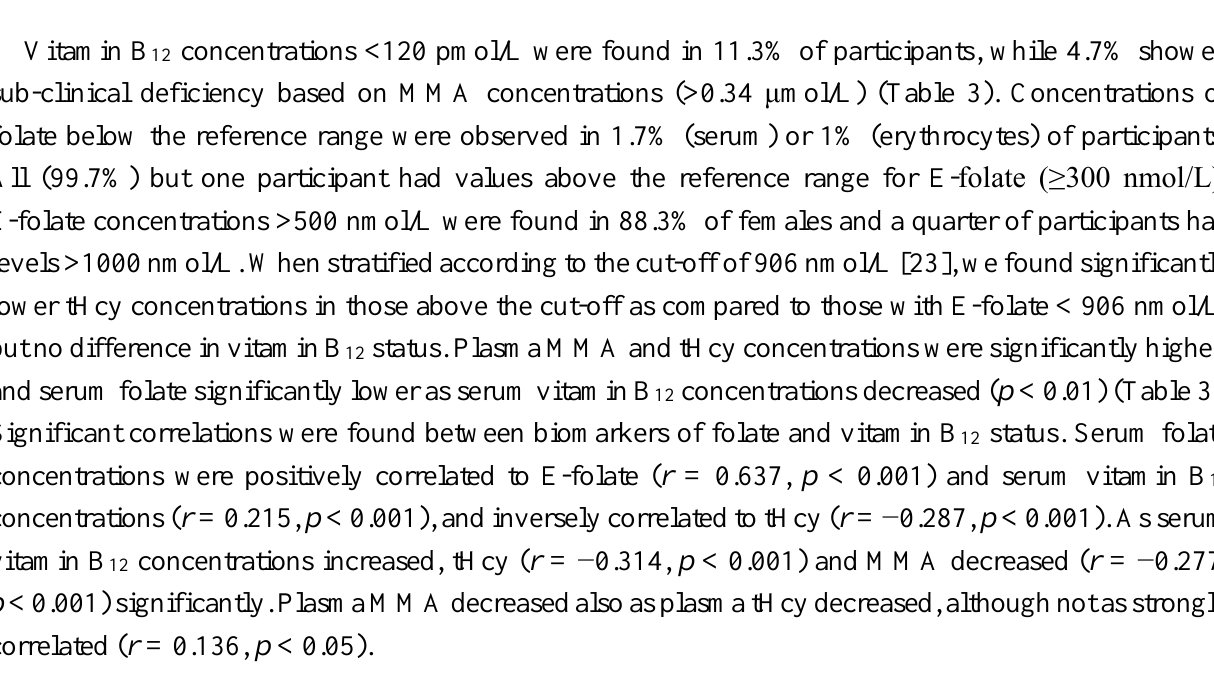
Table 3. Biomarkers of folate and vitamin B 12 stratified by serum vitamin B 12 concentrations 1 . Serum Vitamin B